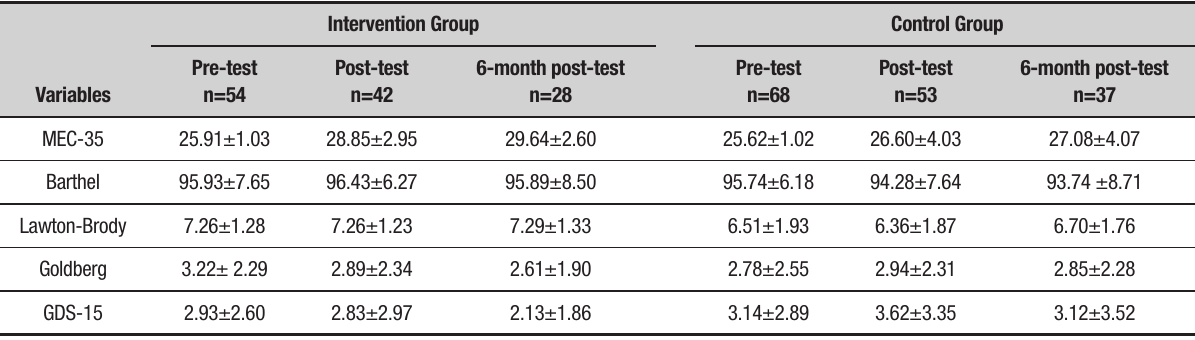
Table 2. Mean±SD of outcome variables.